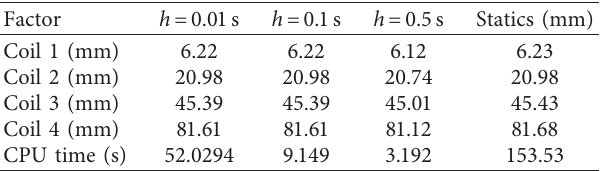
Figure 8: Time evolution of the radius of each spring coil endpoint in the compression process. Table 2: Displacement of each coil with different noise reduction